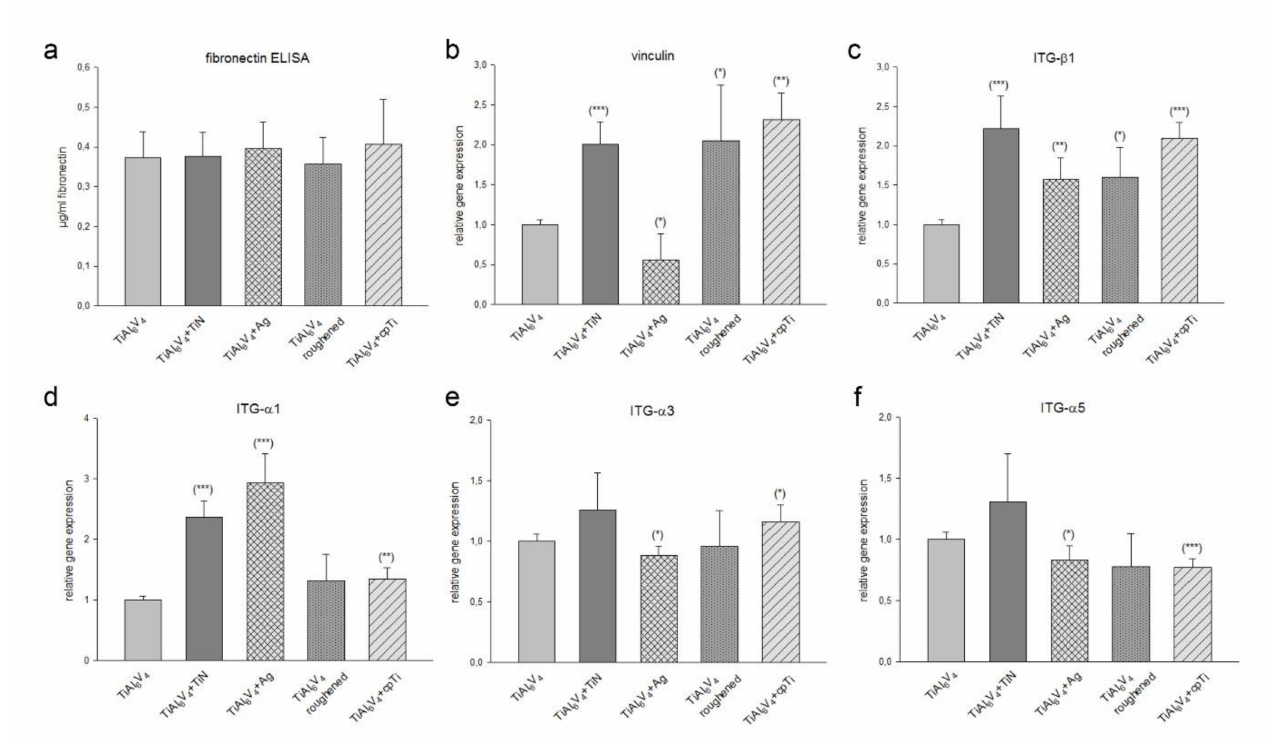
Figure 5. The influence of TiAl 6 V 4 surface modifications on the expression of adhesion molecules. ( a ) Fibronectin expression showed no changes between the groups. The relative gene expression of ( b ) vinculin, and ( c ) the integrin subunits ITG- β 1, and ( d – f ) ITG- α 1, - α 3, α 5 was presented (mean ± SD; n = 8; measured in triplicates). Statistical significances are defined as follows: *** p < 0.001; ** p < 0.01; * p <